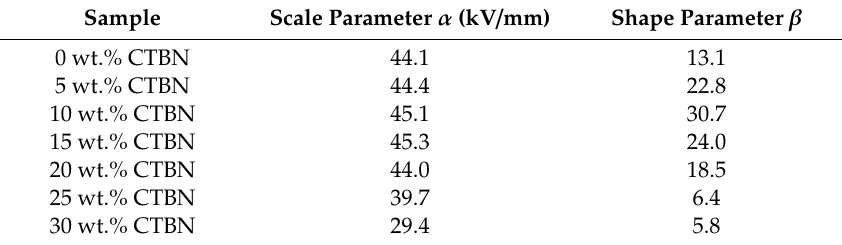
Figure 7. Weibull distribution of composite material breakdown strength. Table 2. Weibull distribution parameters of breakdown strength of samples.